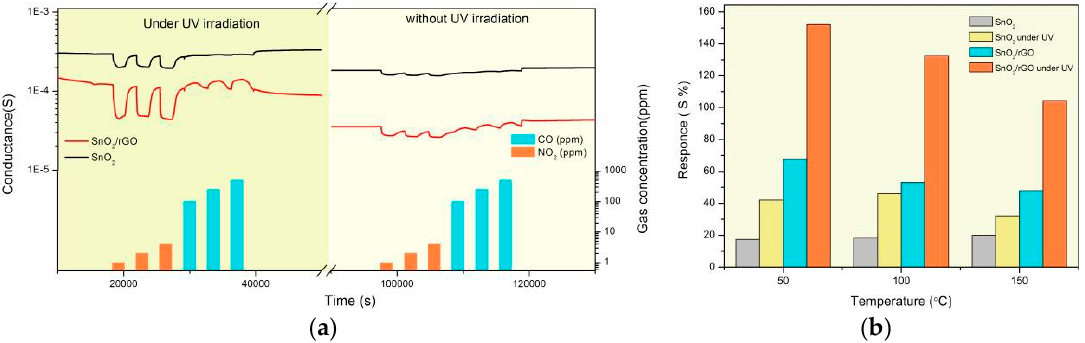
Figure 2. ( a ) Dynamic response of SnO 2 , SnO 2 /rGO composite toward NO 2 (1, 2. 5, 4 ppm), CO (100, 250, 500 ppm) at 50 °C and RH = 40%; ( b ) Sensor responses toward NO 2 (4 ppm) in different working temperature and RH = 40%.